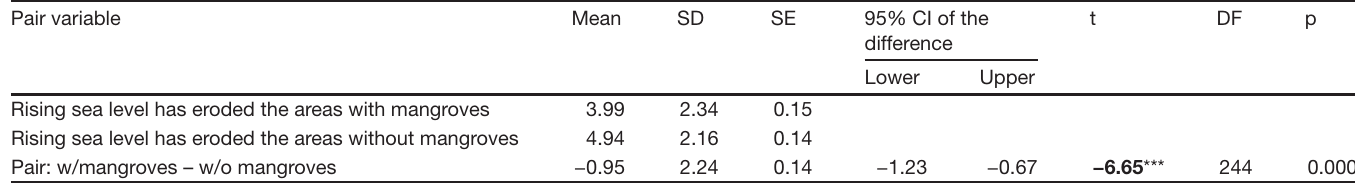
Table A3. Paired samples t-test comparing sea level rise impact on coastal erosion when there are mangroves compared to when there are no mangroves in the coastal areas of Palawan, Philippines Pair variable